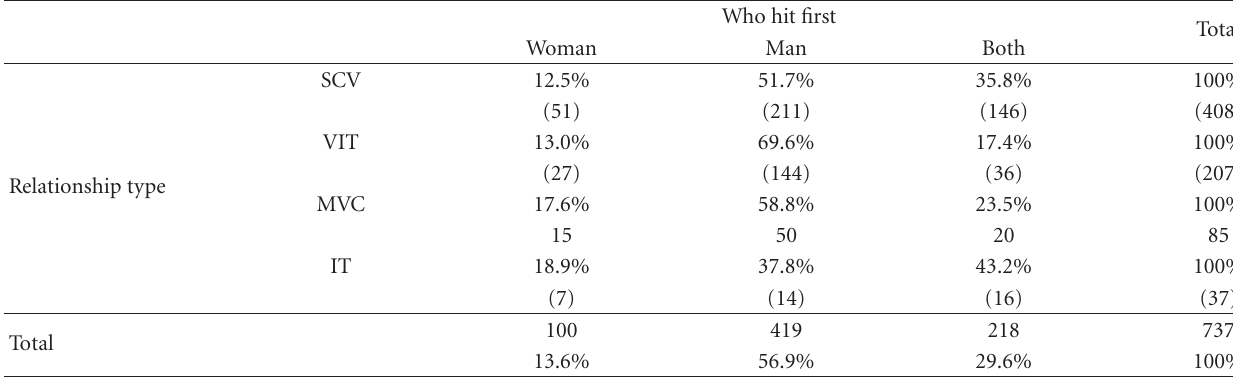
Table 3: Prevalence (and numbers) for violence initiation by relationship type.